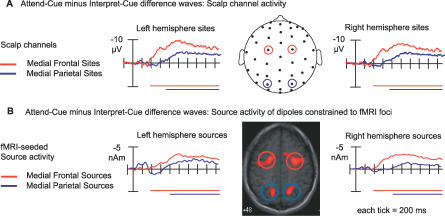
Timing of Activity in the Medial Frontal–Parietal Attentional-Orienting Network(A) Grand-average (n = 13) ERP traces selected from channels located at scalp sites above the medial frontal and medial parietal fMRI foci for the difference waves derived from the contrast of attend cues versus interpret cues. The traces for the frontal and parietal scalp are overlaid, showing the temporal delay for the parietal relative to the frontal scalp sites. Below the ERP traces, the horizontal colored bars indicate the windows in which the attentional-orienting activity across participants was significant at the frontal channels (red) and at the parietal channels (blue).(B) Overlay of the estimated source activity waveforms for the medial frontal and medial parietal sources, separately for each hemisphere, also showing the relative delay for the parietal relative to the frontal sources. These source activity waveforms resulted from source modeling of the grand-average (n = 13) ERP difference wave for attend cues versus interpret cues, using dipoles constrained to fMRI centroids of activity (obtained from Woldorff et. al 2004) [22]. Below the source activity waveforms, the horizontal colored bars represent the windows in which the attentional-orienting activity across participants was significant for the estimated frontal source (red) and parietal source (blue) activity waveforms.